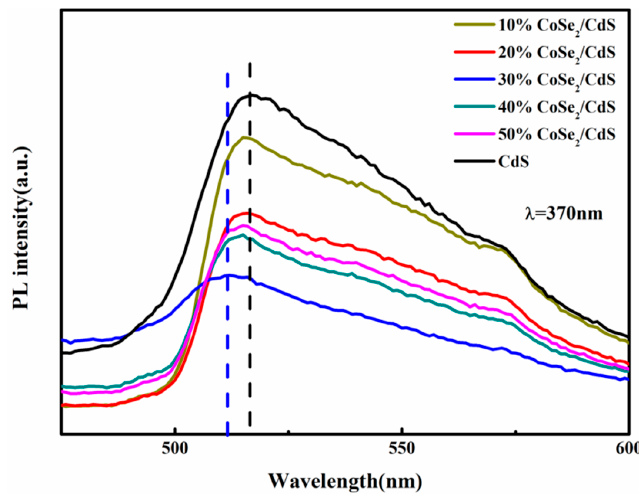
Figure 7. The PL spectra of pure CdS and CoSe 2 / CdS ranging from 10% to 50%.